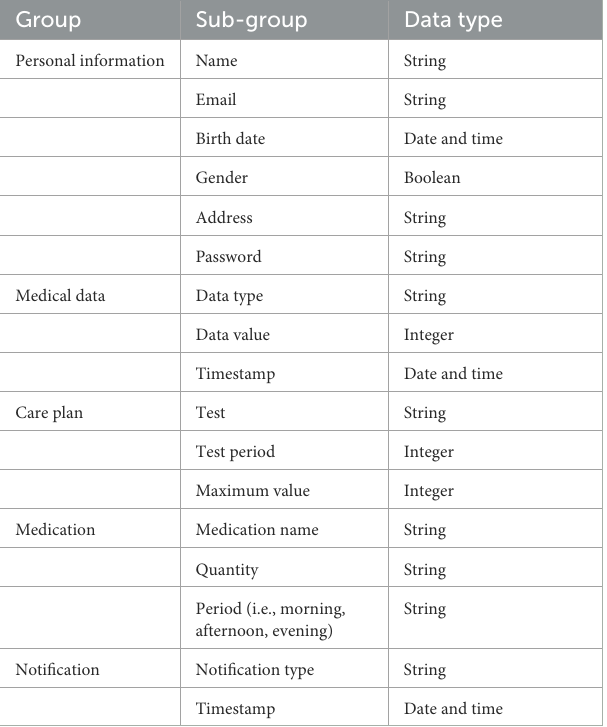
TABLE 4 Database groups, sub-groups and data types. Group Sub-group Data